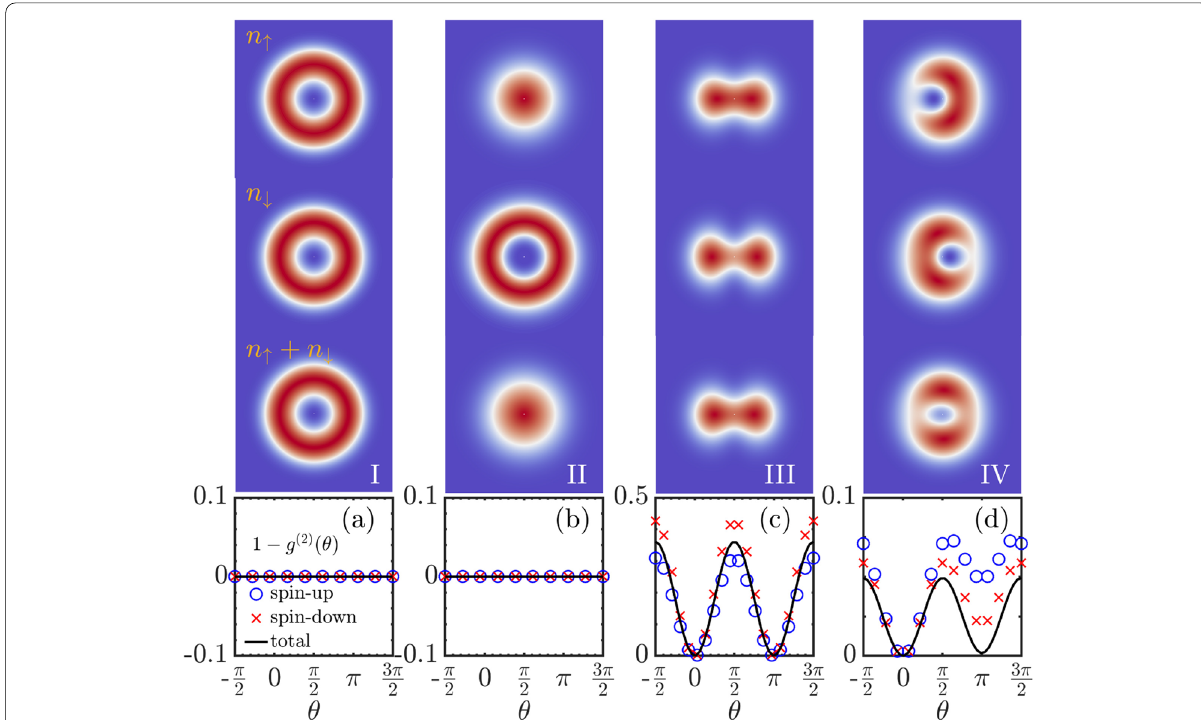
Fig. 5 (Top three panels) Typical spin‑component, total density profiles in four distinct phases. (Bottom panel) In a – d , the corresponding angular g ( 2 ) (θ) is shown. The results for spin‑up, spin‑down, and total density are indicated by circles, crosses, and density‑density correlation function 1 − solid lines, respectively. Here, I is for the vortex‑antivortex pair phase, II is for the half‑skyrmion phase, and III and IV are for angular stripe phases. Adapted from Ref.